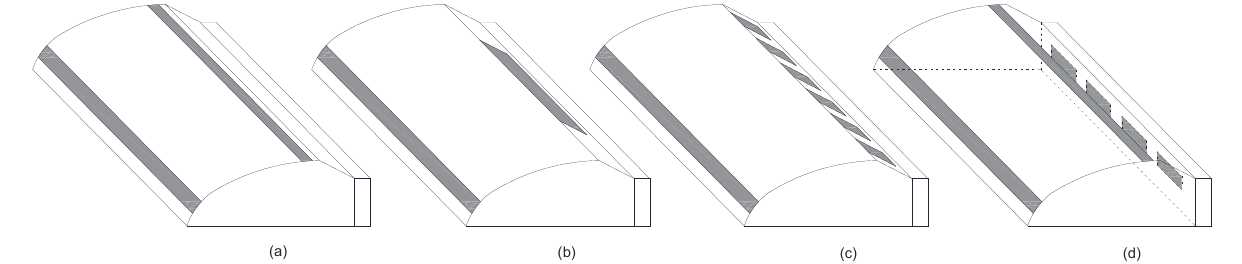
Figure 3. Chinese solar greenhouses with top end vents ( a ), rear slope integral vents ( b ), and rear slope interval vents ( c ) [87], and vents on the back wall ( d )